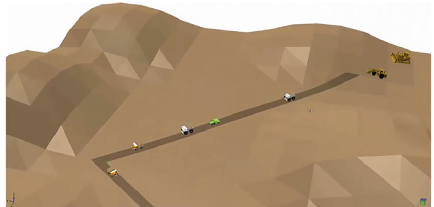
Figure 1: Earthmoving operation as displayed in the